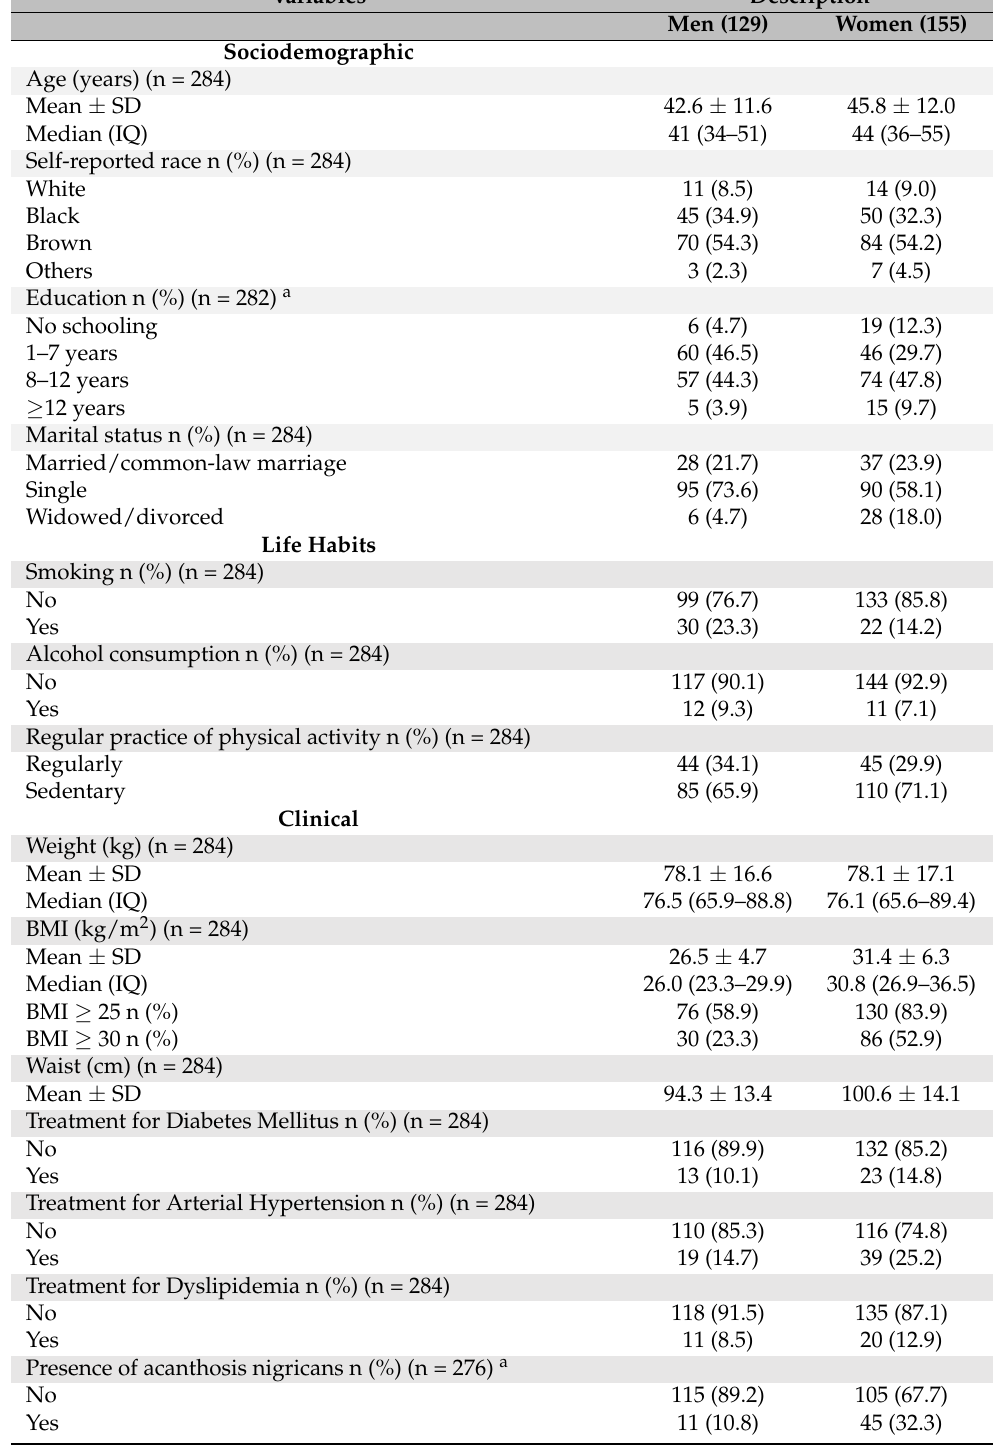
Table 1. General description, by sex, of the total users of a Psychosocial Care Center, who agreed to participate in the study, Salvador, Bahia, Brazil, 2019 (n =